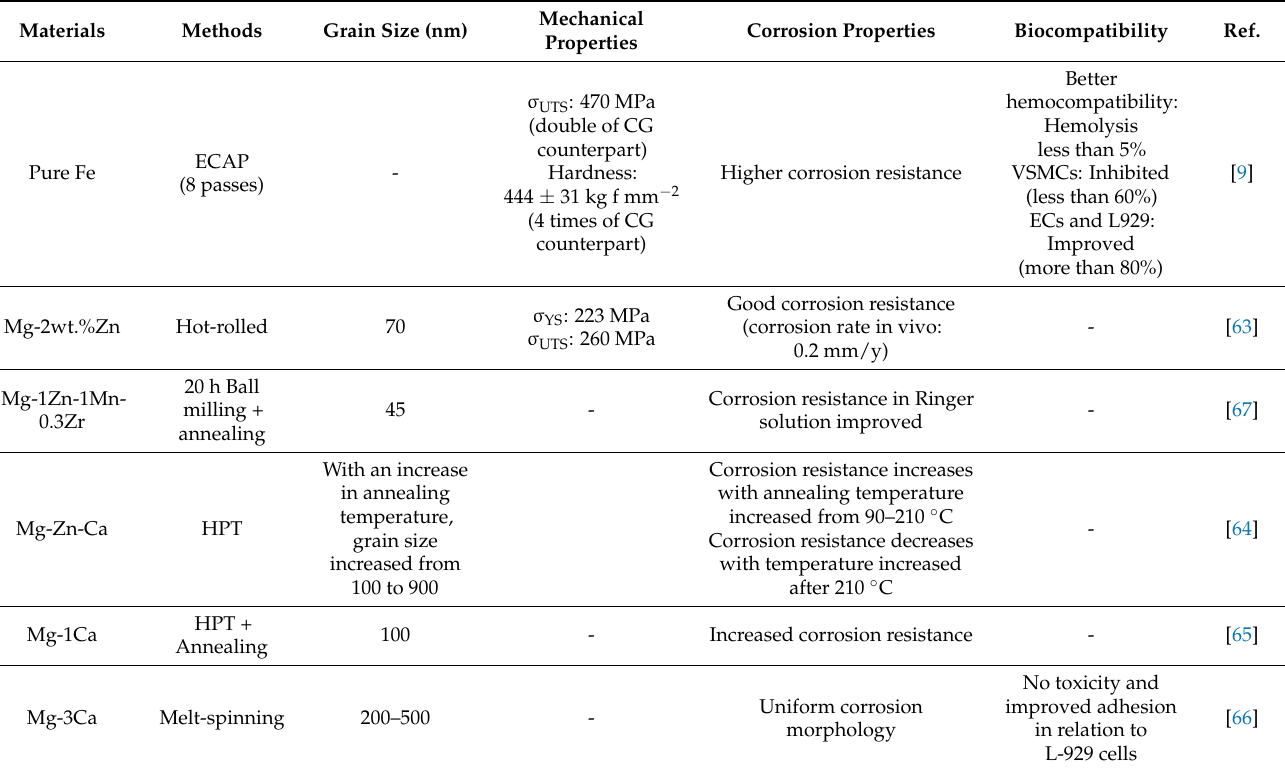
Table 2. Summary of biodegradable nanocrystalline metallic